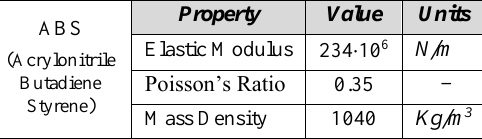
Table 1. The ABS mechanical properties.